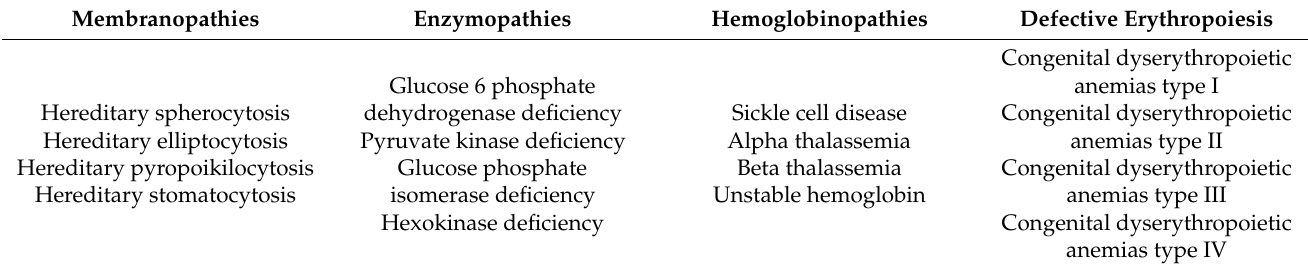
Table 1. Classification of the most common congenital anemias based on pathophysiology